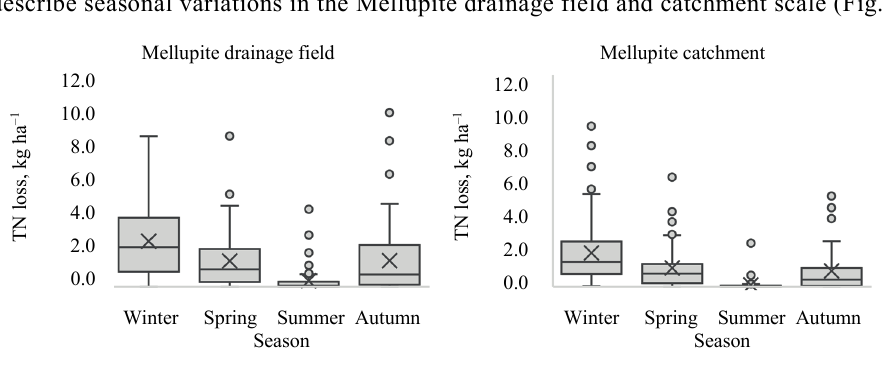
Fig. 6. Seasonal minimum, 25 th percentile, median, 75 th percentile, maximum, outlying values for TN losses (kg ha –1 ) in the Mellupite monitoring site, time period 1995–2020. In the Mellupite drainage field scale higher losses of TN were observed than in the Mellupite catchment scale due to previously described relationship between TN and TP losses (kg ha –1 ) and runoff (mm). The largest dispersion of data for TN loss in the Mellupite drainage field scale was observed during the winter and autumn seasons, from September to February (ranges from 0.01 to 8.52 kg ha –1 in winter and 0.00 to 9.85 kg ha –1 in autumn) and for the Mellupite catchment in the winter and spring seasons, from December to May (ranges from 0.04 to 9.10 kg ha –1 in winter and 0.01 to 6.20 kg ha –1 in spring). The most pronounced losses of TN with the largest amplitude were observed in winter, when plants do not